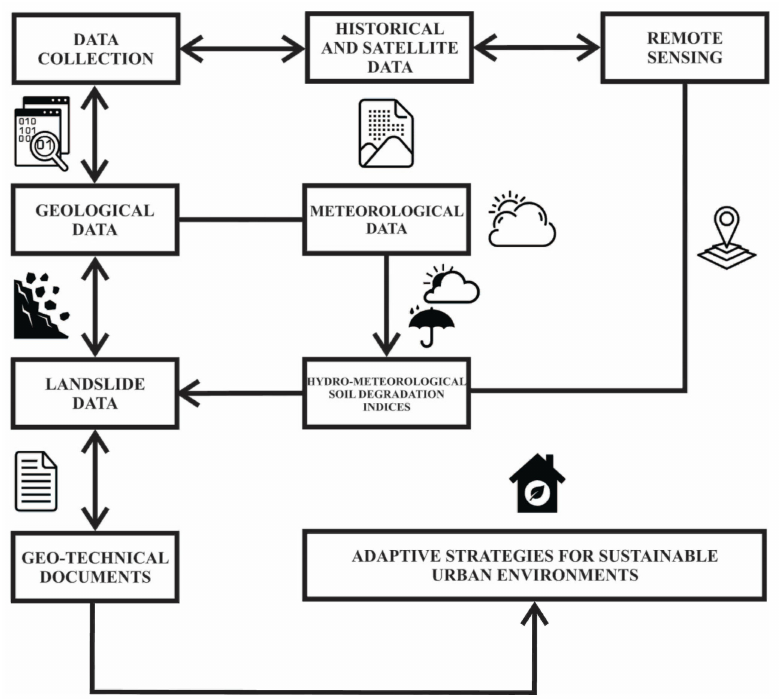
Figure 7. Flow chart of the procedures used in this